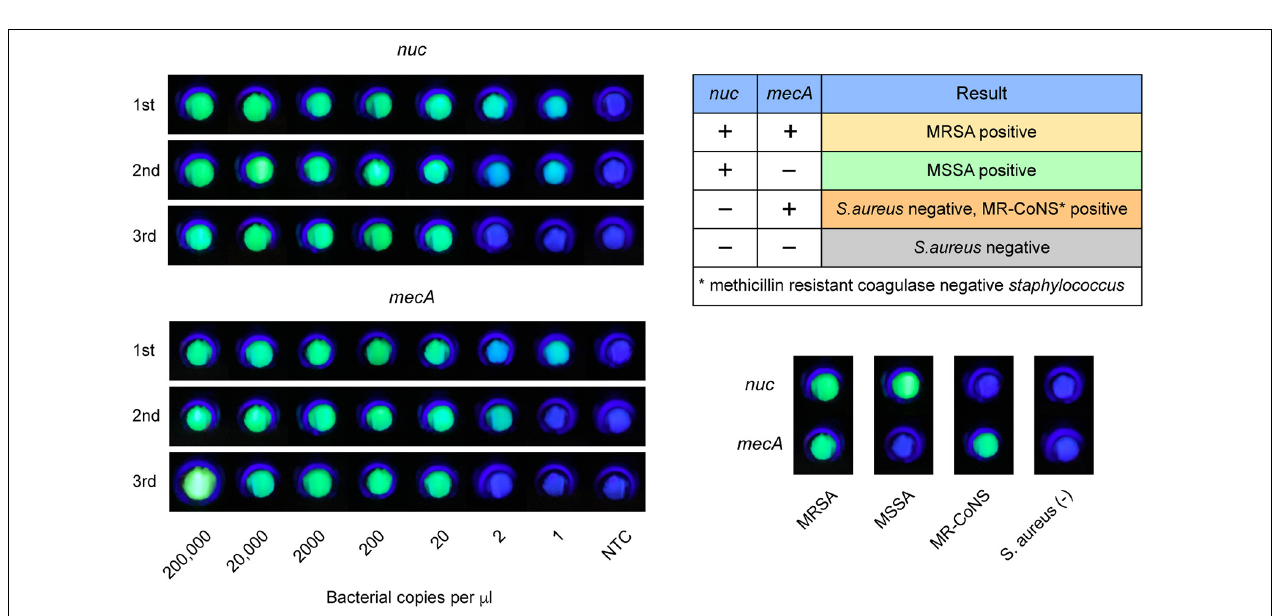
FIGURE 4 | LAMP-CRISPR assay readout. Fluorescent results of MRSA, MSSA, MR-CoNS, and S. aureus are presented at the bottom right. Nuc detection indicates S. aureus positive. MRSA identification requires positive for both nuc and mecA .